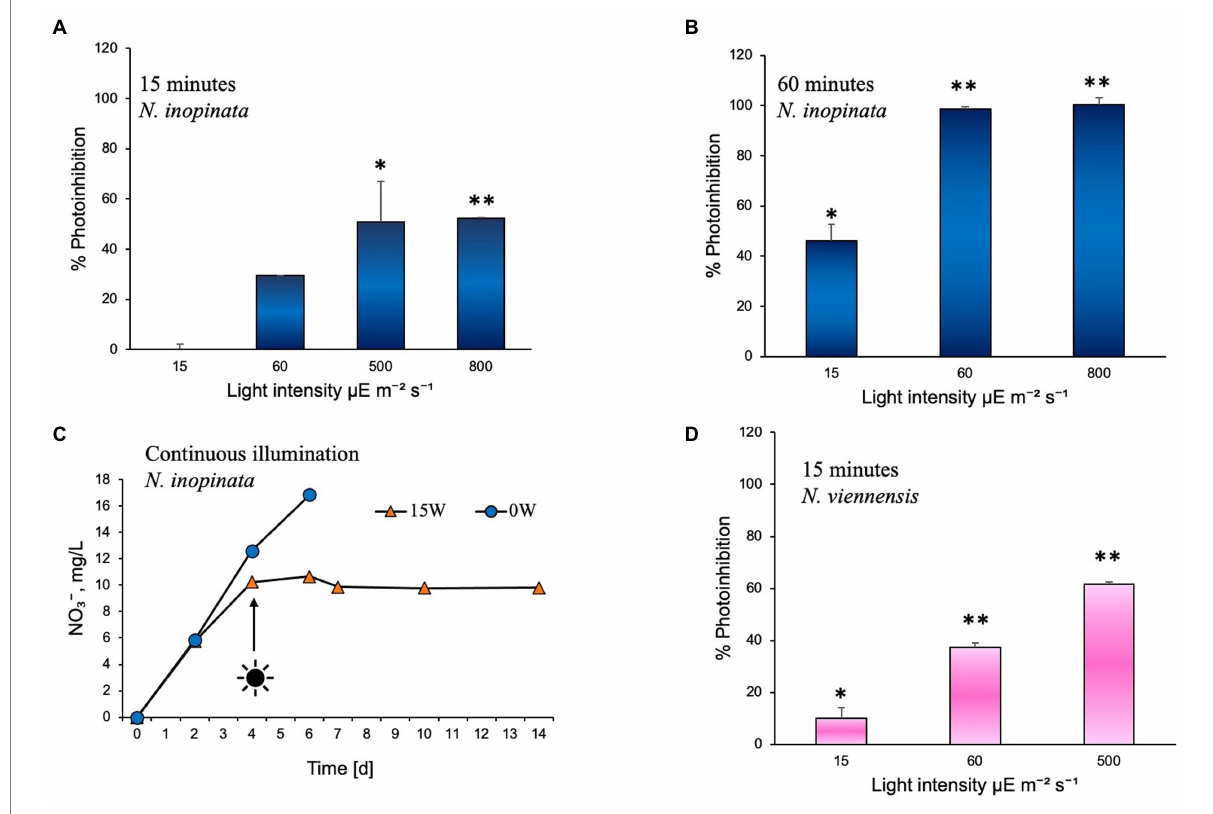
FIGURE 2 Photoinhibition of nitrification activity in Nitrospira inopinata represented as percent reduction of the rate of TON accumulation, compared to the dark control cultures incubated in parallel, after exposure to (A) 15, 60, 500, and 800 μ E m − 2 s − 1 intensities for 15 min, (B) 15, 60, 500, and 800 μ E m − 2 s − 1 intensities for 60 min. (C) Nitrate concentration vs. time during incubation under continuous illumination at 15 μ E m − 2 s − 1 intensity. (D) Photoinhibition of nitrification activity in Nitrososphaera viennensis represented as percent reduction of the rate of TON accumulation, compared to the dark control cultures incubated in parallel, after exposure to 15, 60, and 500 μ E m − 2 s − 1 intensities for 15 min. Data are presented as the mean and standard error of triplicate cultures. Error bars are smaller than symbol size in panel C. Significant differences between control and illuminated cultures are represented as * p < 0.05 and ** p <